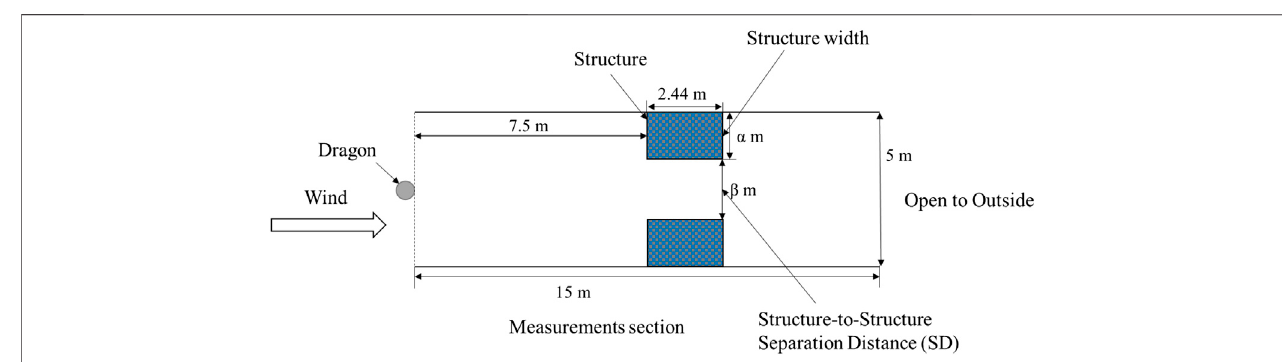
FIGURE 2 | Schematics of structure locations in wind